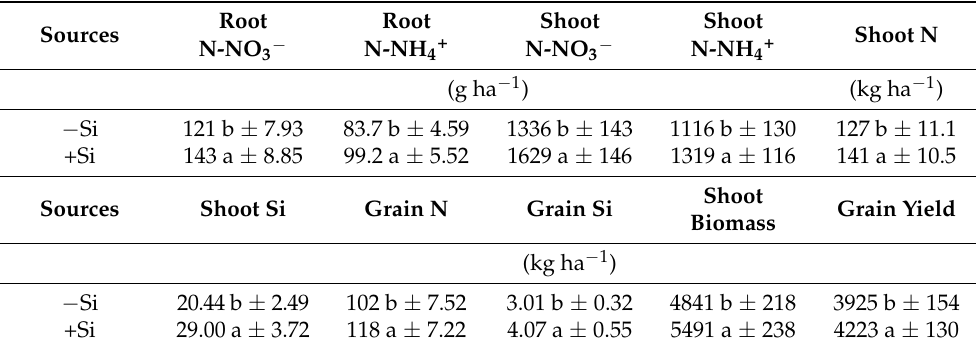
Table 4. Wheat root nitrate (N-NO 3 − ); root ammonium (N-NH 4+ ) accumulation; shoot N-NO 3 − ; shoot N-NH 4+ ; shoot N; shoot Si accumulation; grain N; grain Si accumulation; shoot biomass and grain yield as a function of Si amendment application.